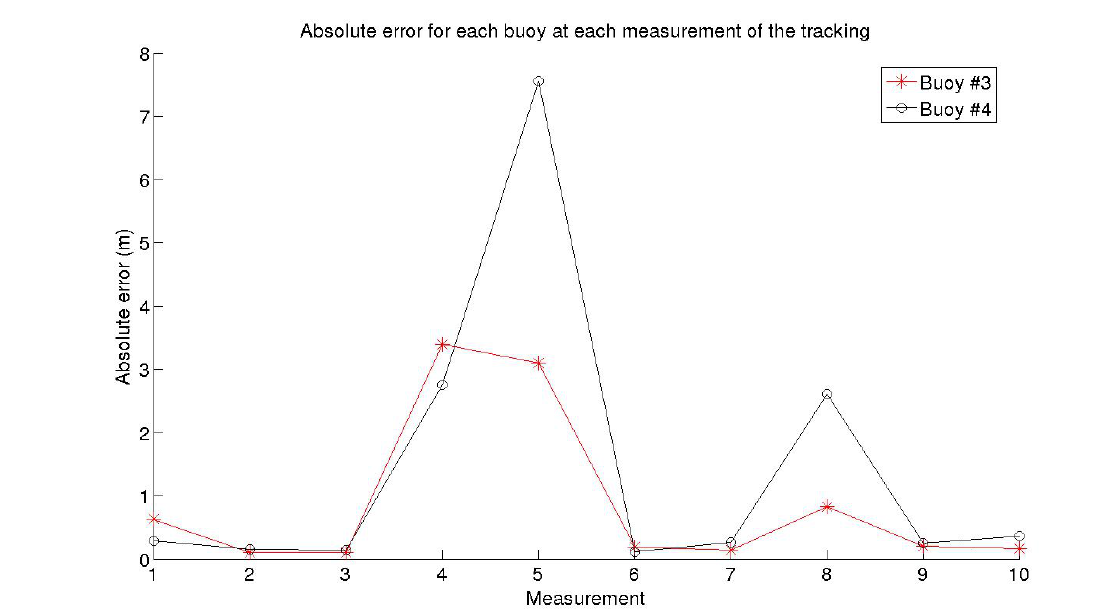
Figure 8. Absolute error for each buoy at each